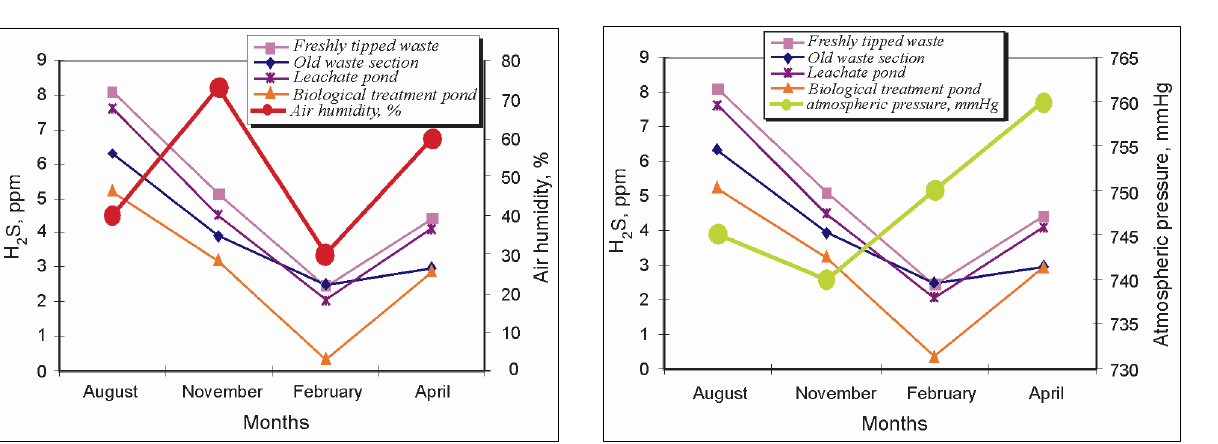
Fig. 5. H 2 S concentration dependence on air temperature